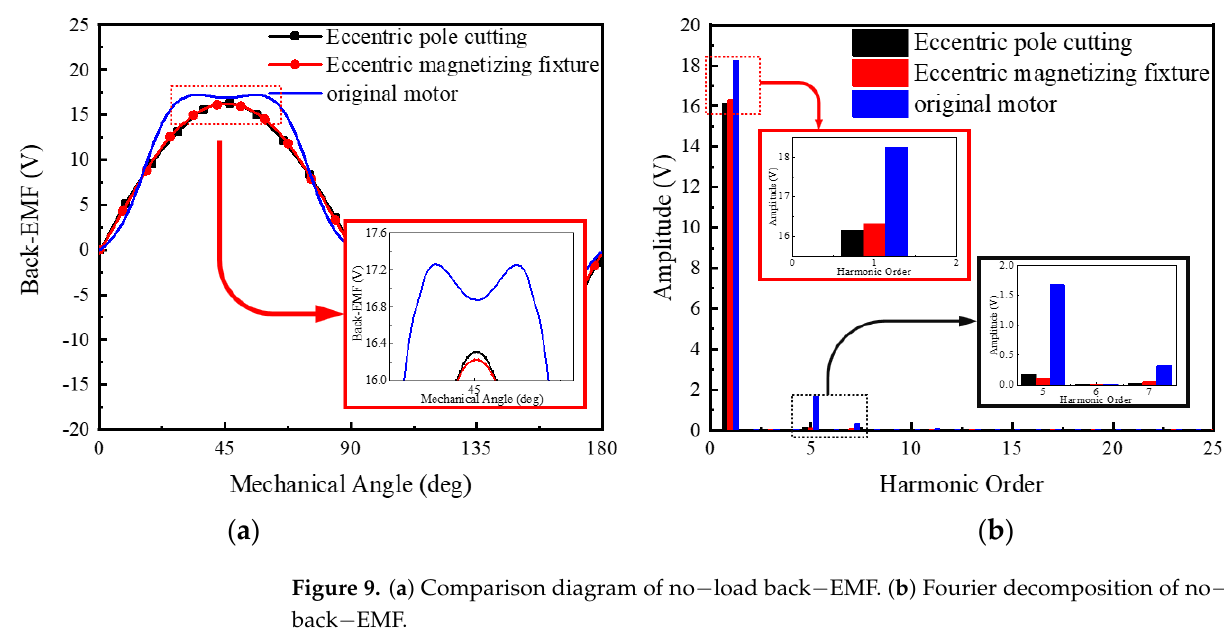
Figure 9. ( a ) Comparison diagram of no−load back−EMF . ( b ) Fourier decomposition of no−load back−EMF .